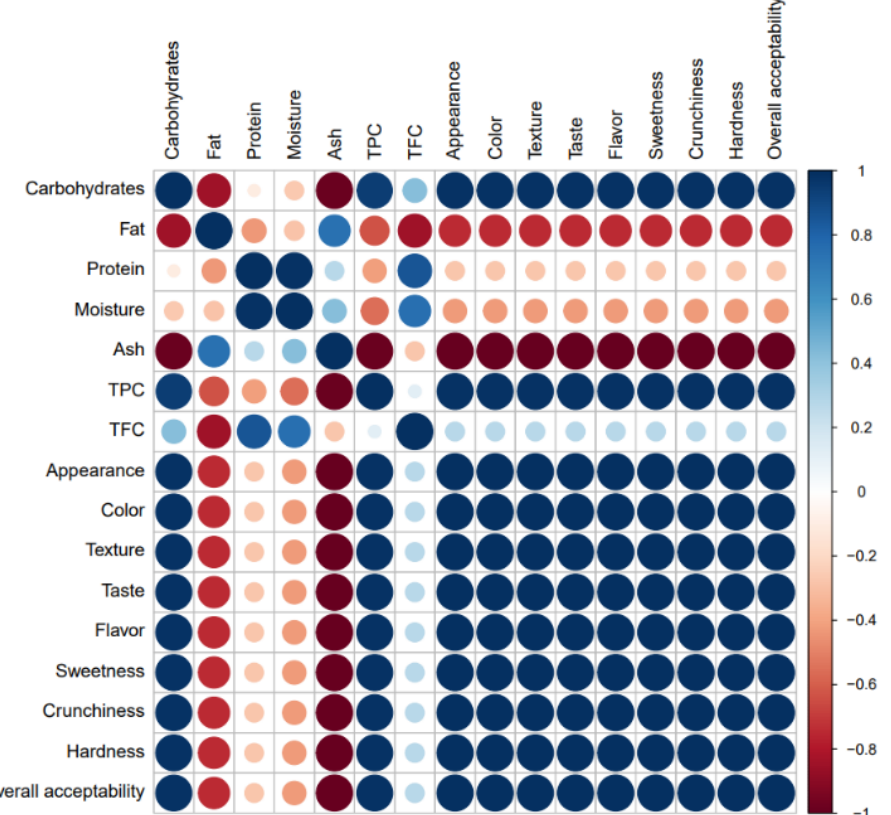
Figure 4. Correlation heatmap between macronutrients, TPC, TFC, and sensory attributes of func- tional cookies enriched with chestnut shells extract evaluated by a color diagram.